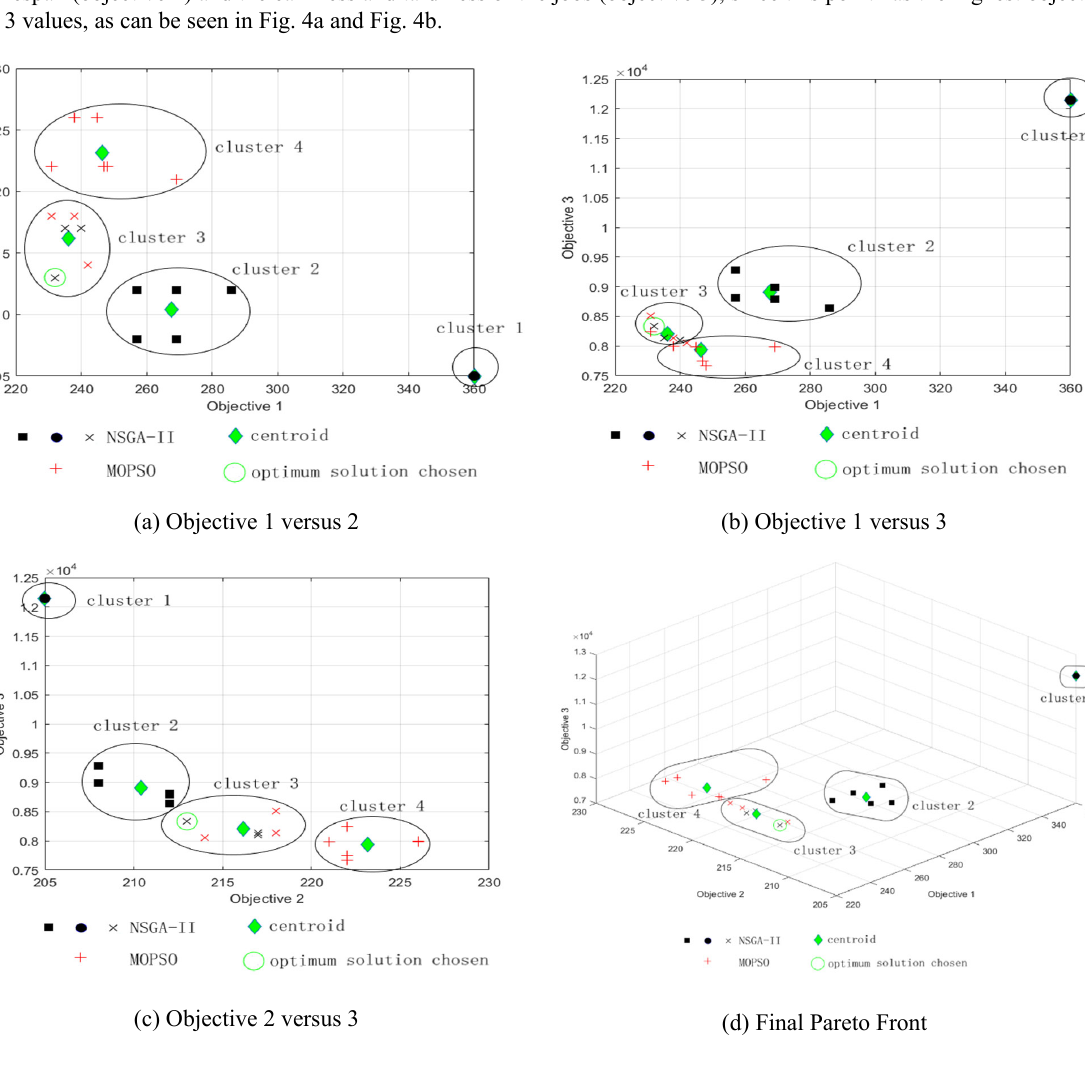
Fig. 4. Pareto Front in the first